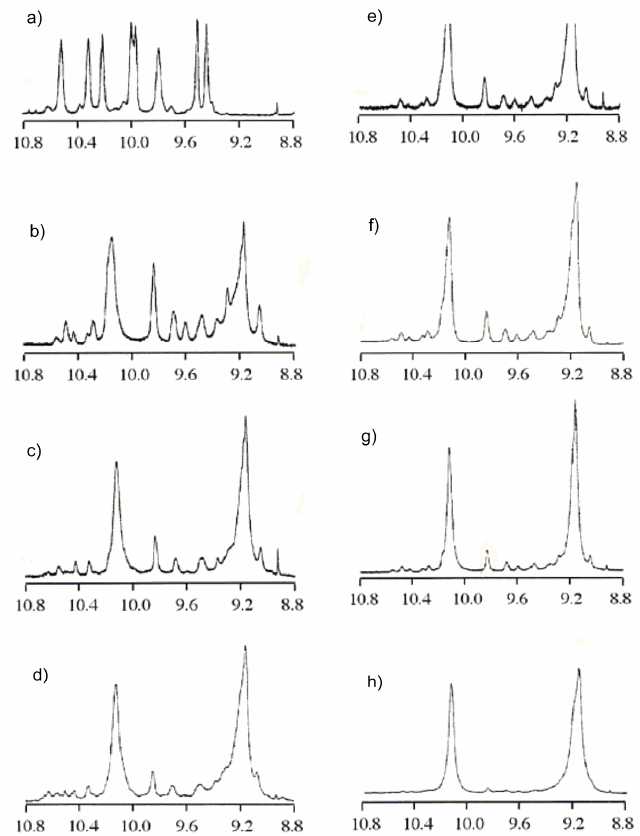
Figure 2. 1 H-NMR spectra of CDMPC-2 ( a ); CDMPC-7 ( b ); CDMPC-11 ( c ); CDMPC-18 ( d ); CDMPC-19 ( e ); CDMPC-24 ( f ); CDMPC-26 ( g ) and CDMPC-124 ( h ) in pyridine- d 5 at 80 °C (400 MHz).